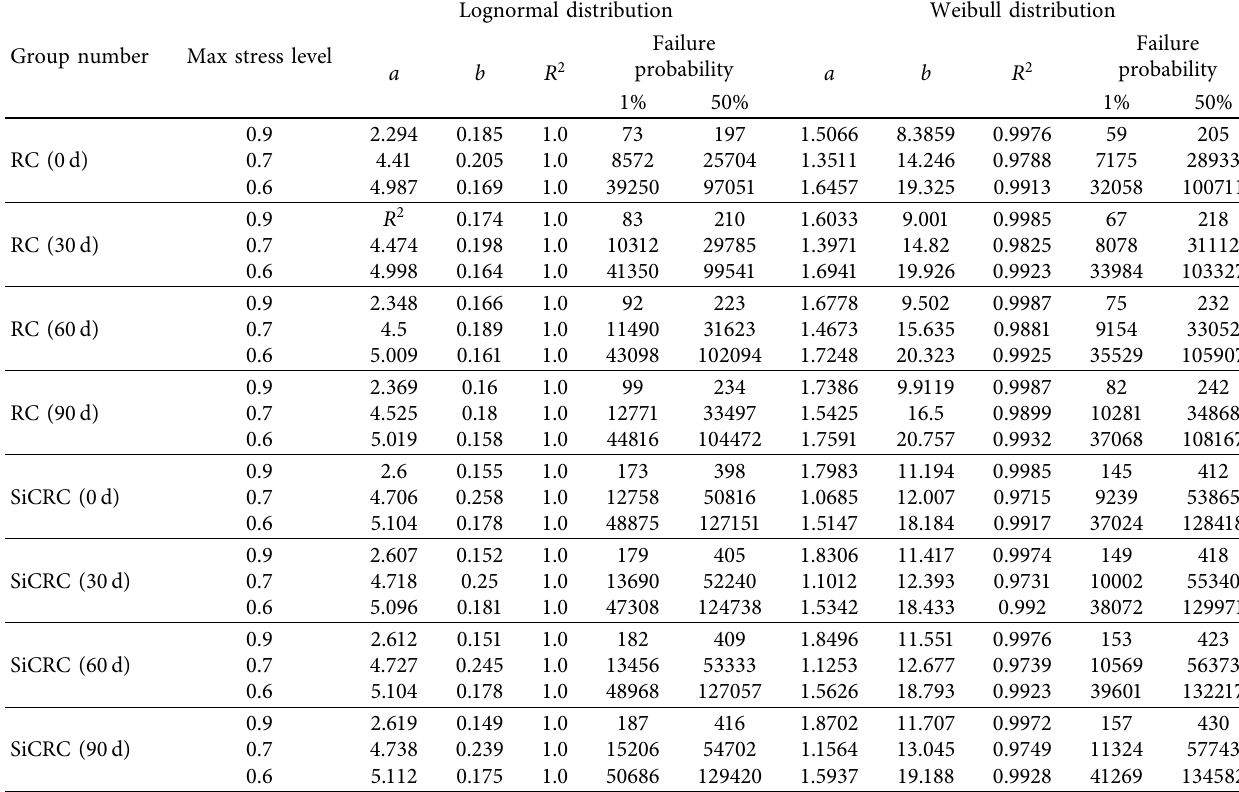
Table 5: Fitting results of lognormal distribution and Weibull